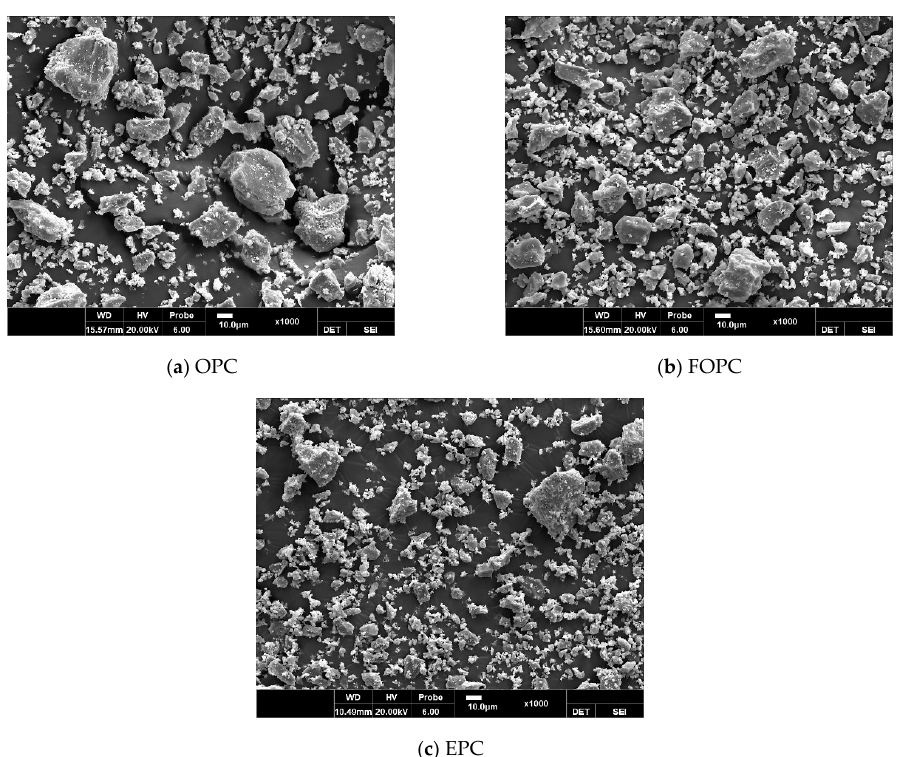
Figure 3. Particle size distribution for OPC, FOPC, and EPC.